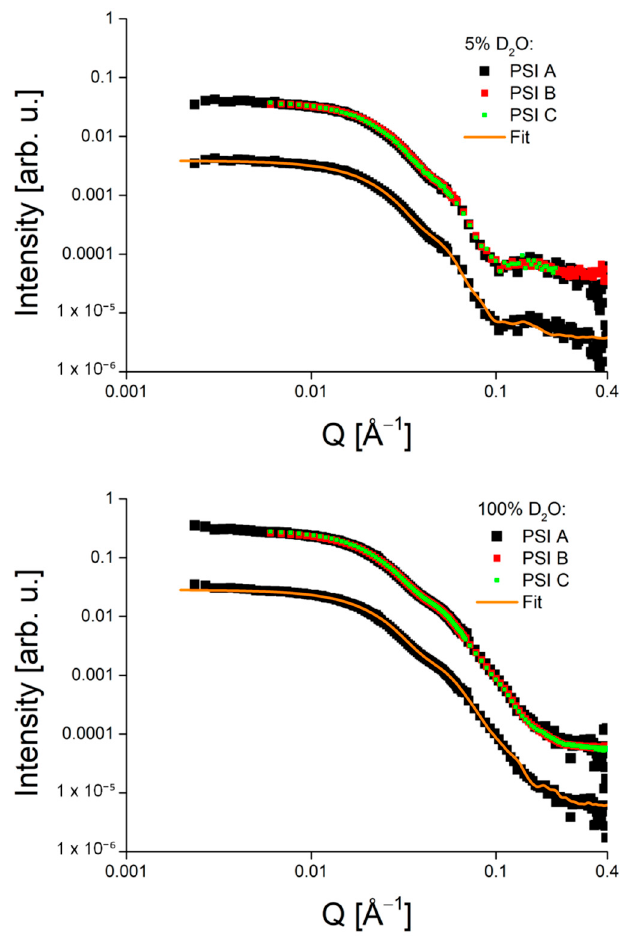
Figure 7. Comparison of SANS data of three different preparations of the PSI– β DM complex PSI A, B, and C (see text), respectively, in 5% (upper panel) and 100% D 2 O (lower panel). The data fit produced by Dammif is shown for one of the data sets in each panel as a solid orange line. For ease of inspection, the latter data set is given an artificial offset of one order of magnitude.